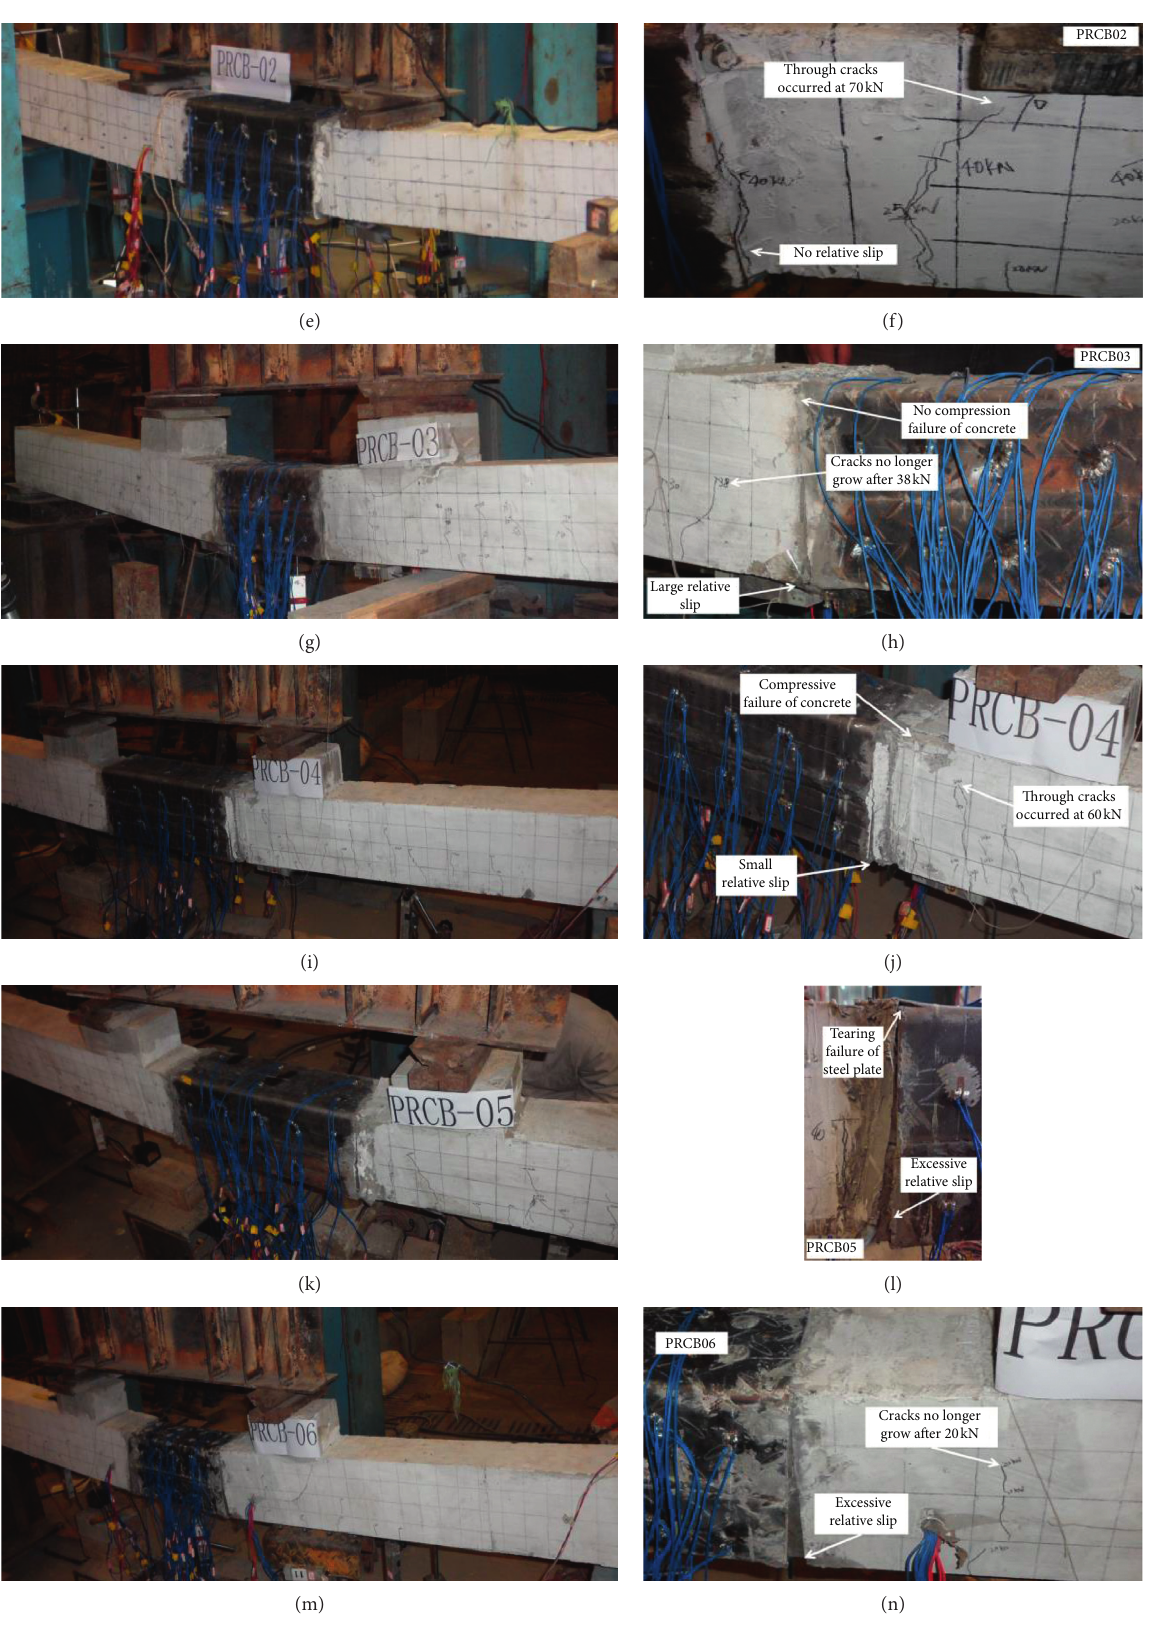
Figure 7: Loading diagram and failure modes. (a) PRCB-00 loading diagram, (b) PRCB-00 ultimate failure mode, (c) PRCB-01 loading diagram, (d) PRCB-01 ultimate failure mode, (e) PRCB-02 loading diagram, (f) PRCB-02 ultimate failure mode, (g) PRCB-03 loading diagram, (h) PRCB-03 ultimate failure mode, (i) PRCB-04 loading diagram, (j) PRCB-04 ultimate failure mode, (k) PRCB-05 loading diagram, (l) PRCB-05 ultimate failure mode, (m) PRCB-06 loading diagram, and (n) PRCB-06 ultimate failure